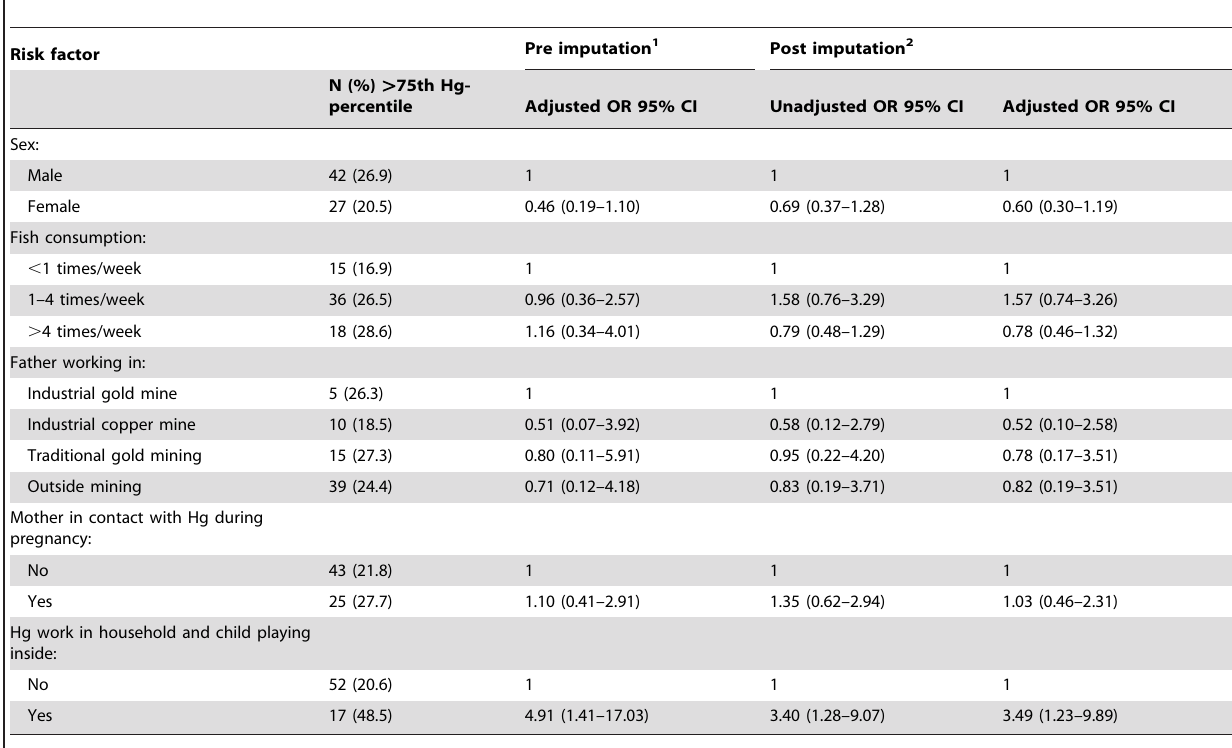
Table 4. Main risk factors for mercury exposure above the 75th percentile (0.165 m g/g).